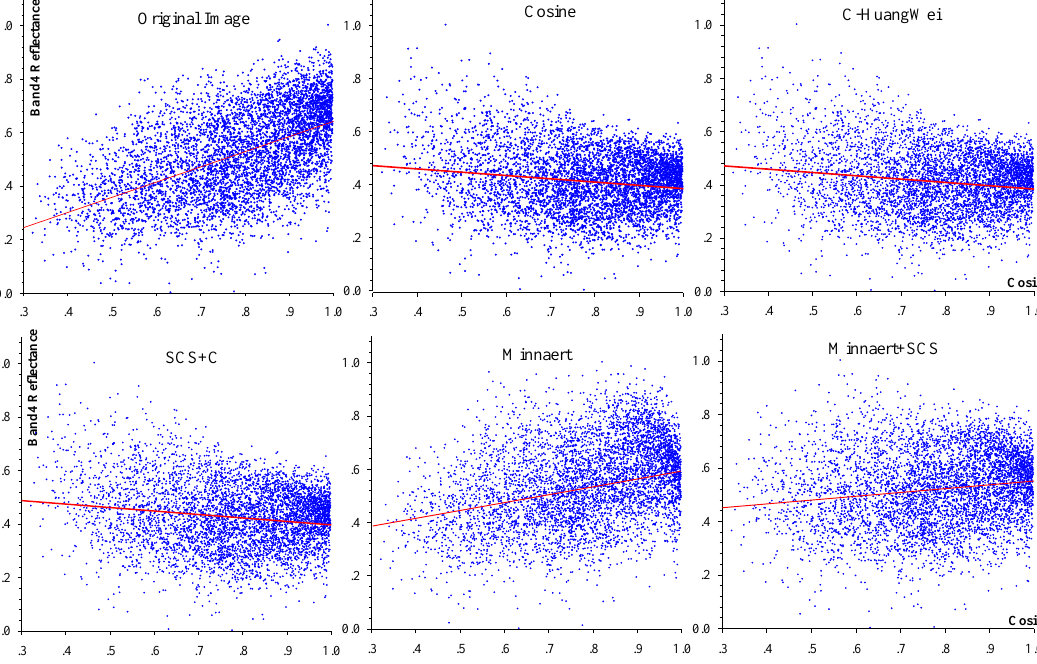
Figure 7. Scatter plots and the linear regression fitting lines of reflectance band4 and cosi before and after